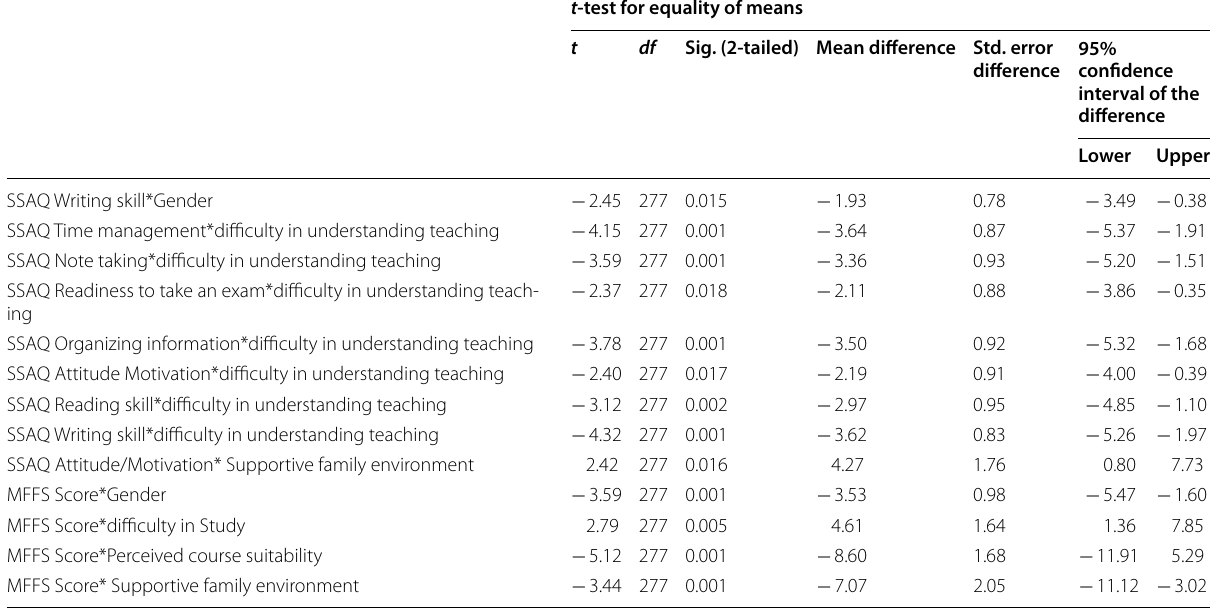
SSAQ Study Skills Assessment Questionnaire; MFFS McMaster Family Function Scale